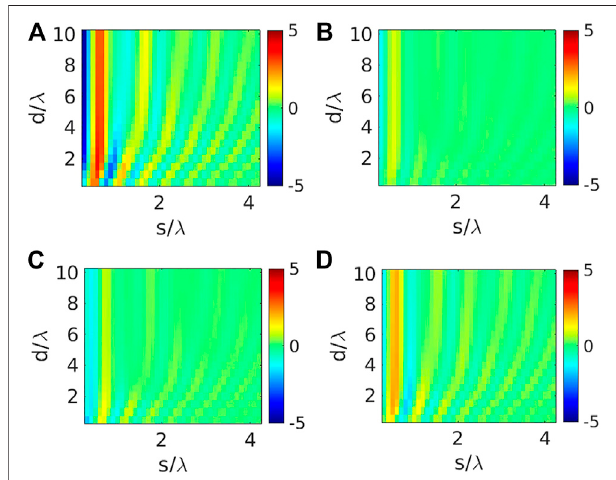
FIGURE 4 | Variation of Δ P (in dB) considering 4 × 4 IRS near Tx-dipole (see Figure 1 ), considering the input impedance Z in , L for individual loops